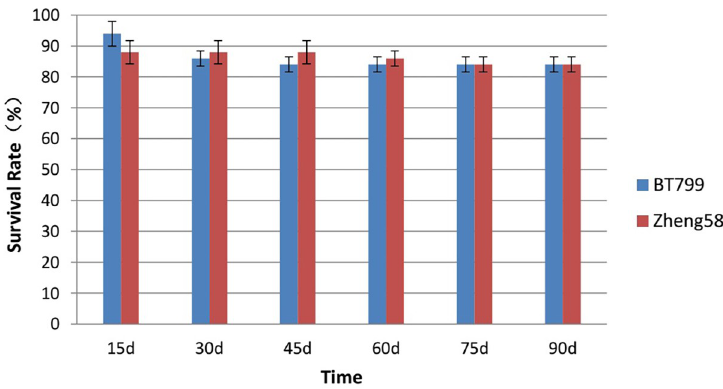
Fig 1. Effects of Bt maize on the survival rate of E . fetida , from six investigations. Values are means ± SE, n = 5.